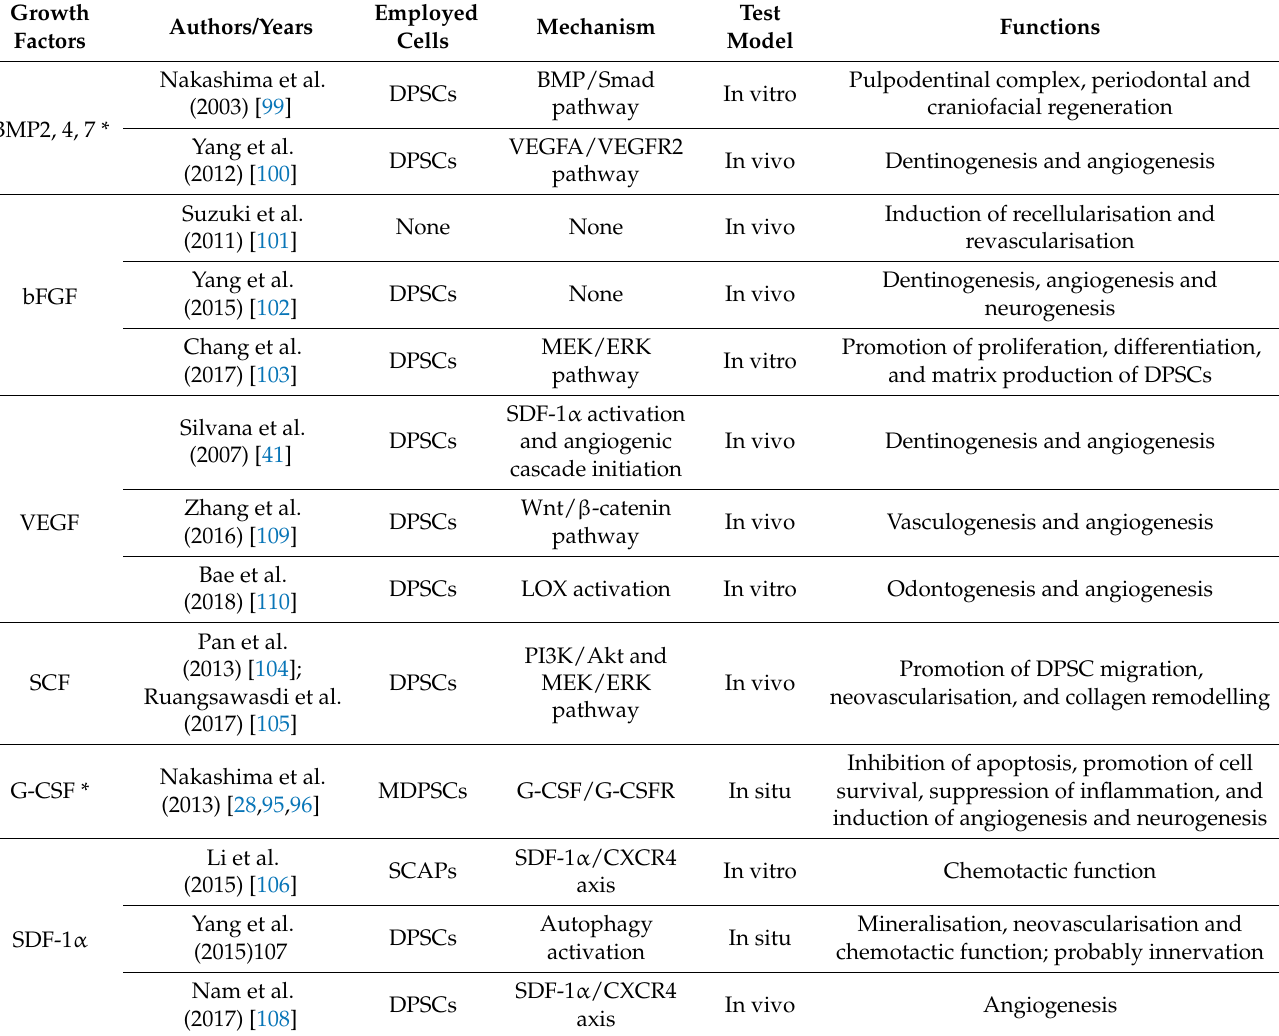
Table 6. Growth factors used for pulp/dentin